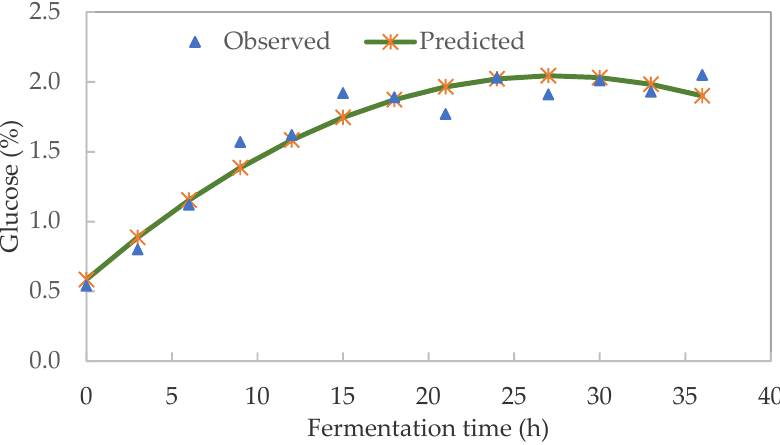
Figure 3 . Effect of fermentation time on the glucose content of pearl millet slurry during fermentation.